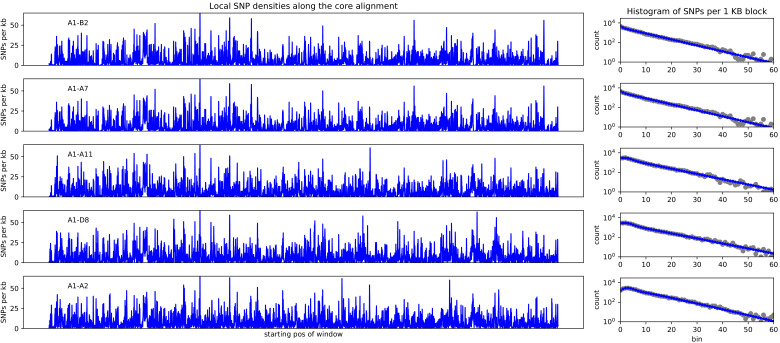
Left panels: SNP densities (SNPs per kilobase) along the core genome for the five pairs of strains (A1-B2), (A1-A7), (A1-A11), (A1-D8), and (A1-A2).Right panels: Corresponding histograms for the number of SNPs per kilobase (dots) together with fits of the mixture model. Note the vertical axis is on a logarithmic scale.